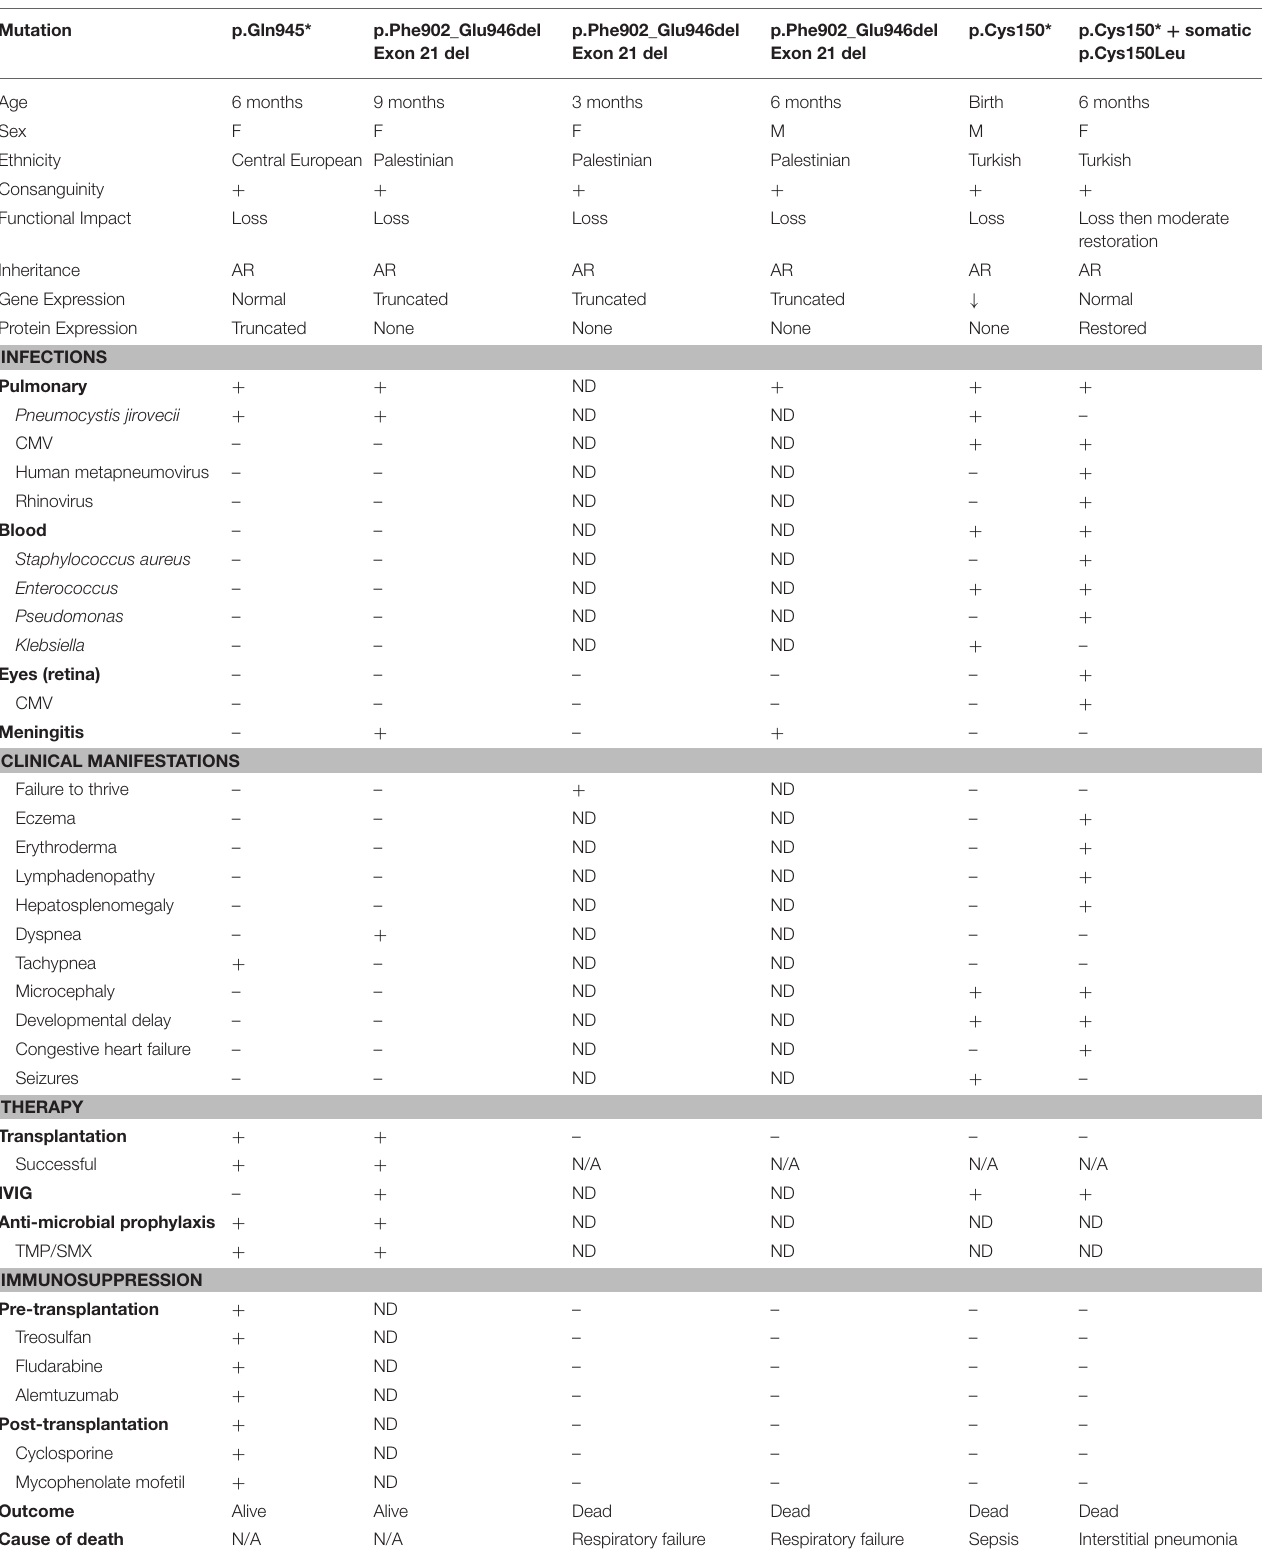
TABLE 2 | Clinical and laboratory phenotype of human CARD11